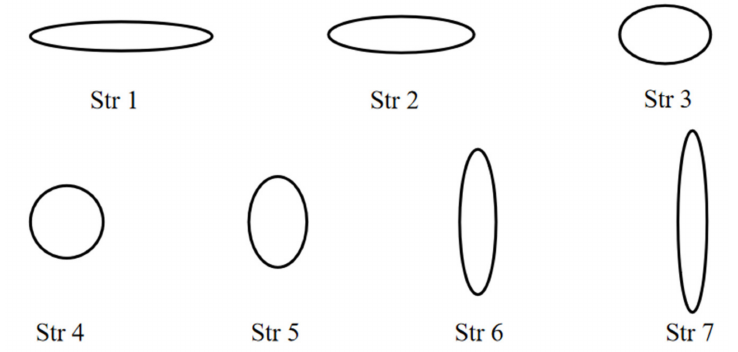
Figure 3. Structure diagram of different radius ratios of oval discharge